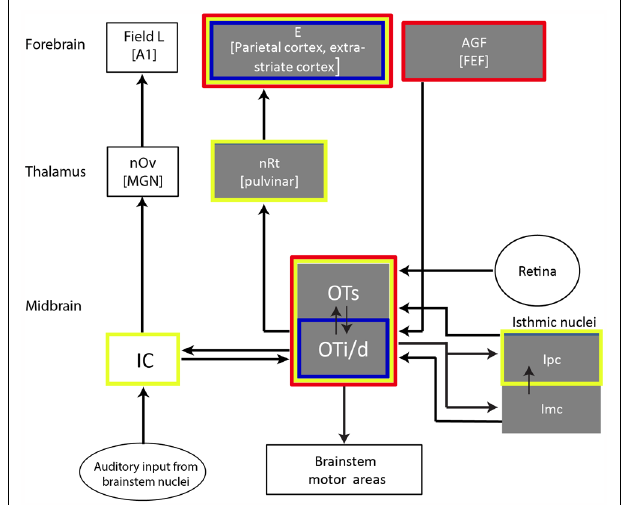
FIGURE 2 | Illustration showing a selected part of the barn owl’s auditory pathway with the OT as a hub. Gray boxes indicate structures suggested to be related to gaze and attention control.The red outline indicates structures where SSA was reported; the blue outline indicates areas where long-term adaptation was reported (habituation-like responses); the yellow outline indicates structures where multisensory (visual/auditory) neurons were reported. Double-headed arrows indicate reciprocal connections. Abbreviations of names of structures appear within each box.The abbreviations of names of the equivalent mammalian structures are in parentheses: E, entopallium; AGF, arcopallium gaze fields; FEF, frontal eye fields; nRt, nucleus rotundus; OTs, superficial layers of the OT (layers 1–10); OTi/s, intermediate and deep layers of the OT (layers 11–15); IC, inferior colliculus; Ipc, nucleus isthmi pars parvocellularis; Imc, nucleus isthmi pars magnocellularis; nOv, nucleus ovoidalis; MGN, medial geniculate body; A1, auditory cortex